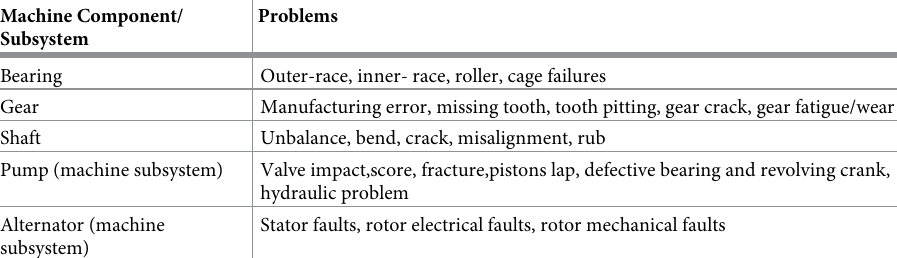
Table 1. Common machine component and machine subsystem problems in PHM